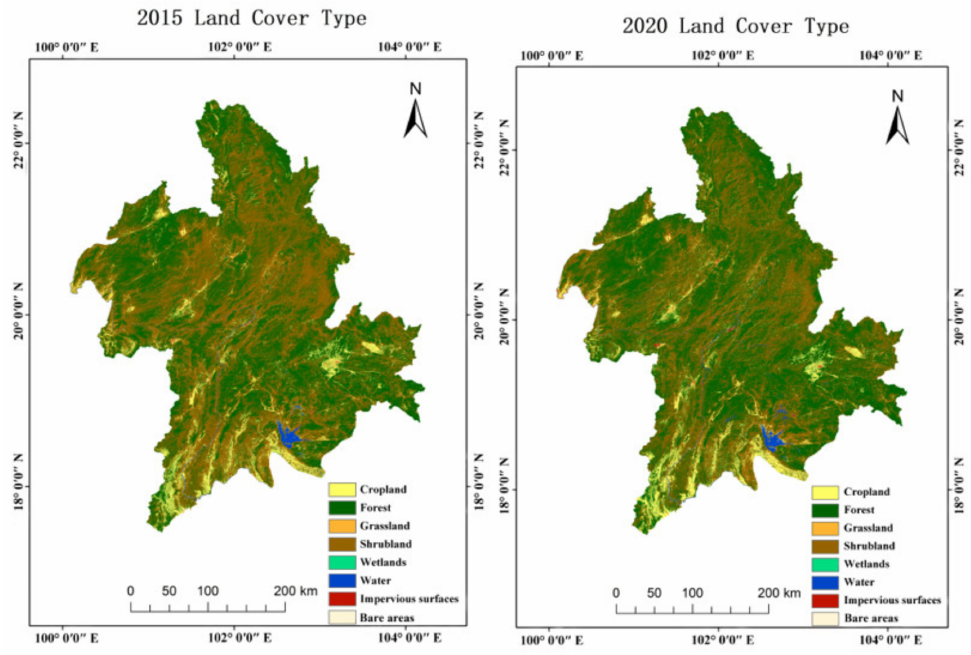
Figure 10. GLC_FCS30 2015 and 2020